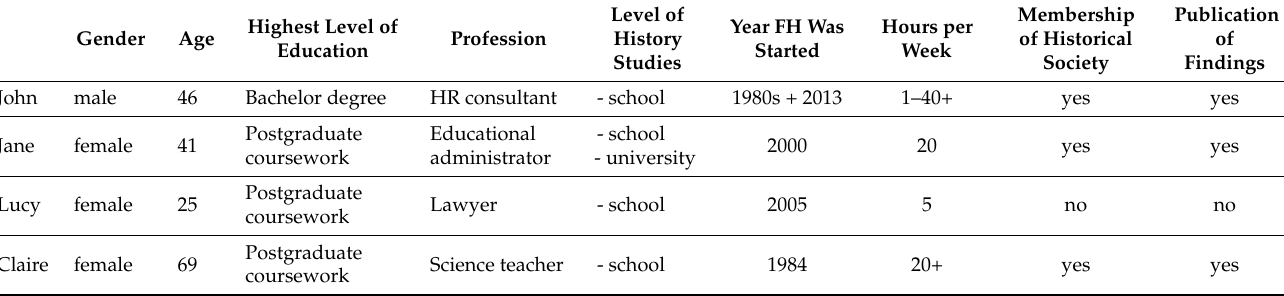
Table 2. Demographic overview of case study